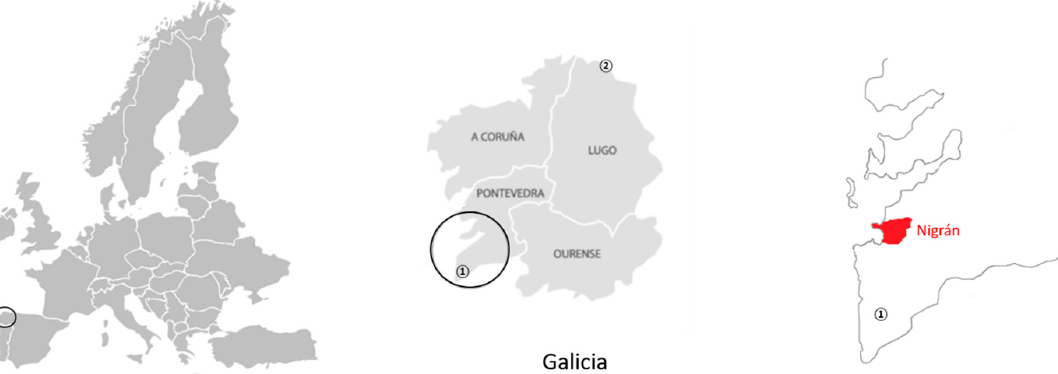
Figure 1. The left image shows the location of Galicia in Europe. The center image shows a map of Galicia marking the two districts where V. velutina was first detected in 2012: (1) O Rosal and (2) Burela. The right image shows the sampling region (Nigr á